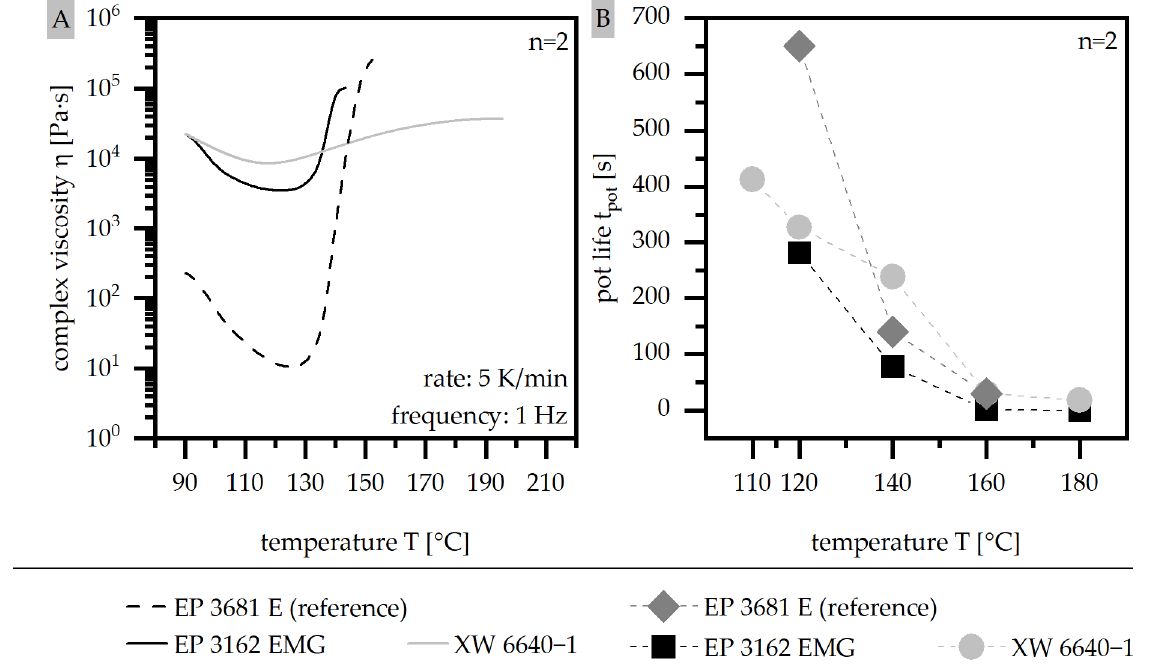
Figure 4. Route of complex viscosity η (dynamic measurement) ( A ) and pot life t pot (isothermal measurement) ( B ) compared for two EP types and the reference material.